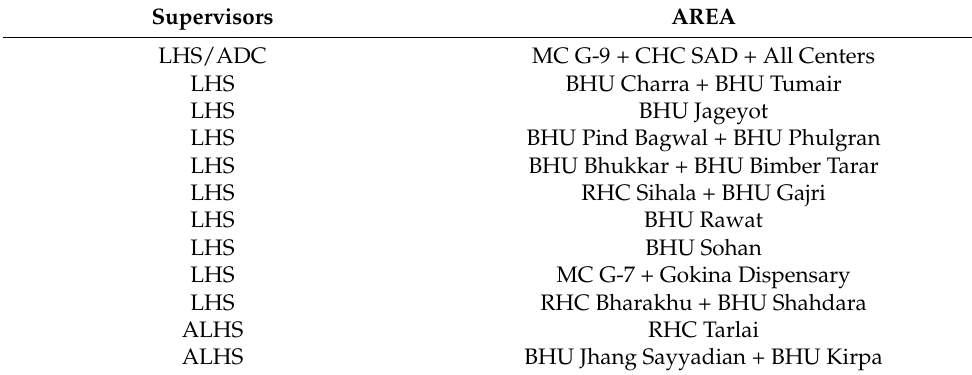
Table 5. The LHS trained for the rural